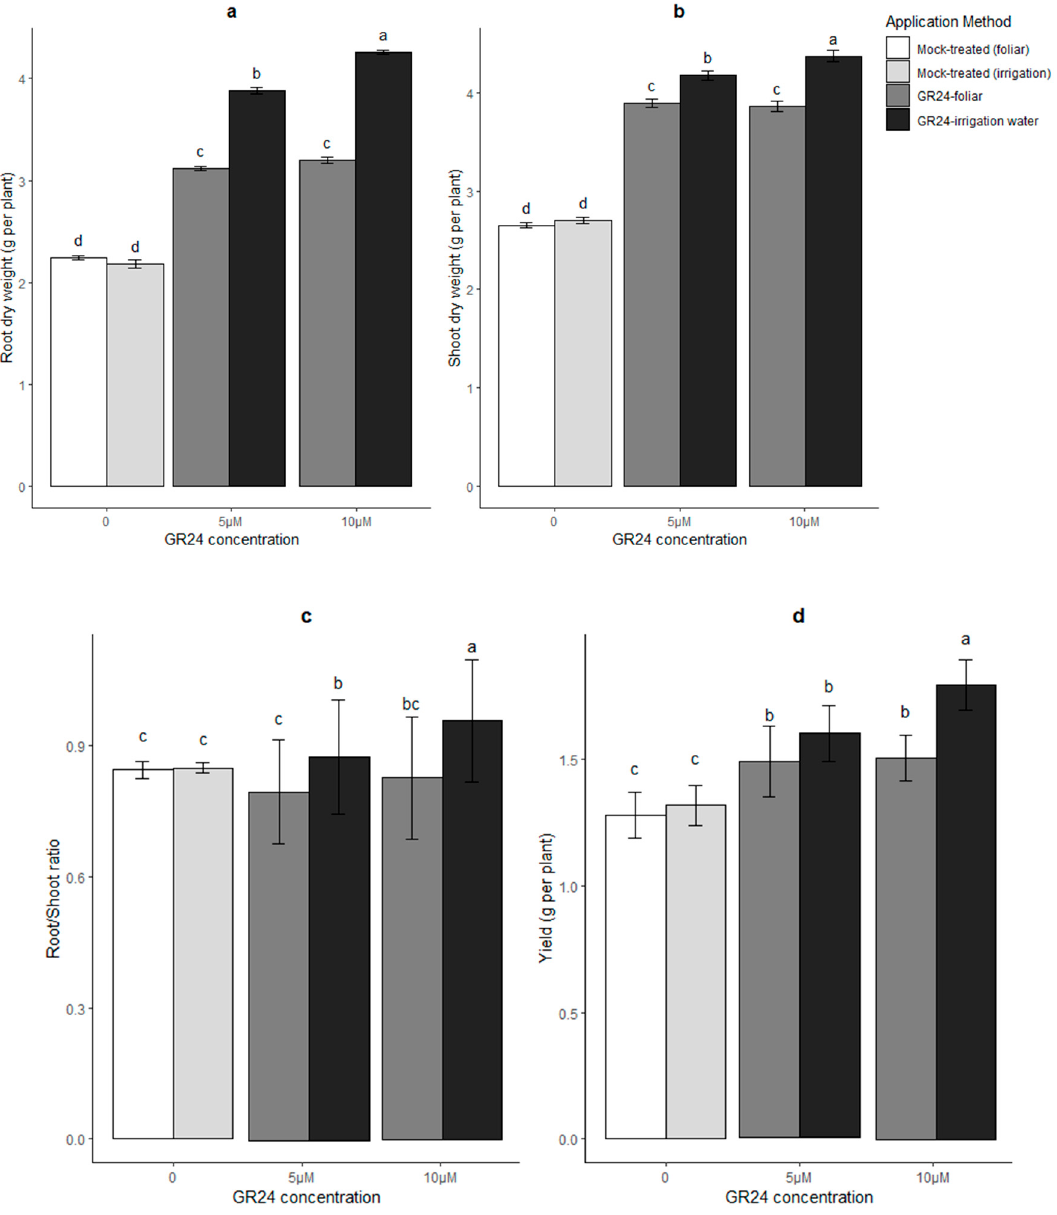
Figure 2. Root dry weight ( a ), shoot dry weight ( b ), root/shoot ratio ( c ) and yield ( d ) in wheat plants in response to two methods of GR24 application under drought stress conditions. Mock-treated plants in these graphs were equally drought- stressed but received a water and acetone solution; for irrigated control values, see Supplementary Materials Figure S2. Each value represents the mean ± SE ( n = 4, each replicate the pool of four plants). Different letters on top of bars indicate significantly different means for p ≤ 0.05 (LSD test).